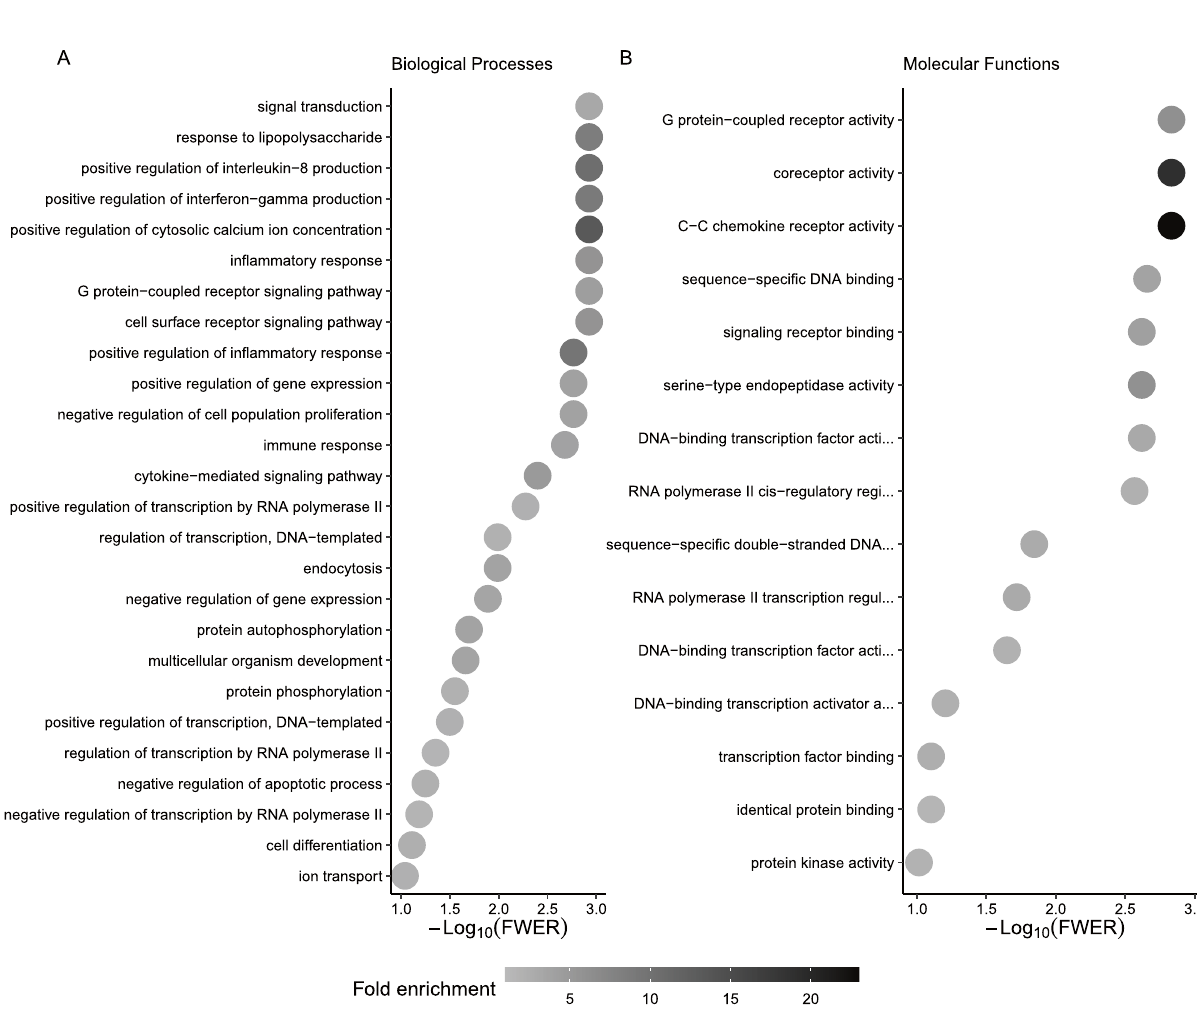
Figure 6. Gene ontology categories enriched in the genes with lower transcript abundance at 24 h versus one h. ( A ) Biological processes and ( B ) Molecular functions. To improve readability, only categories with more than five genes are displayed on the graphs, please see Supplementary Table S4 and S5 for a full list of categories and the associated genes with their